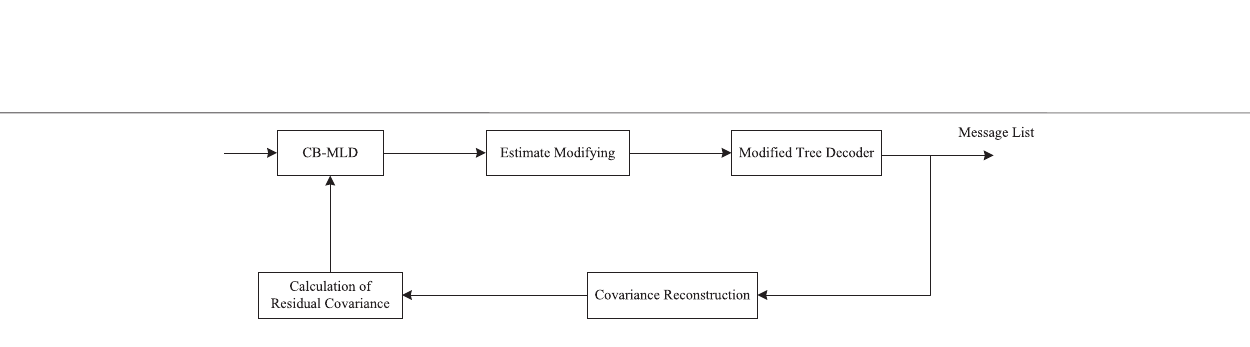
FIGURE 6 | Block diagram of the proposed iterative receiver for common information.